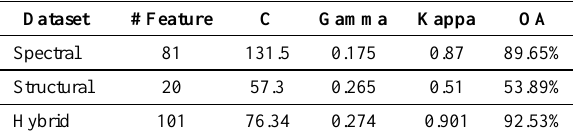
Table 4. Results of the proposed